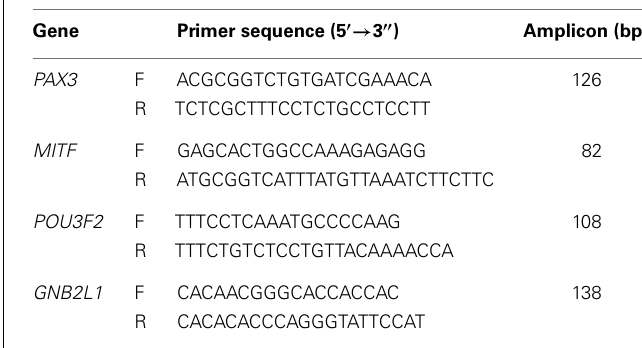
Table 1 | PCR primers and amplicon